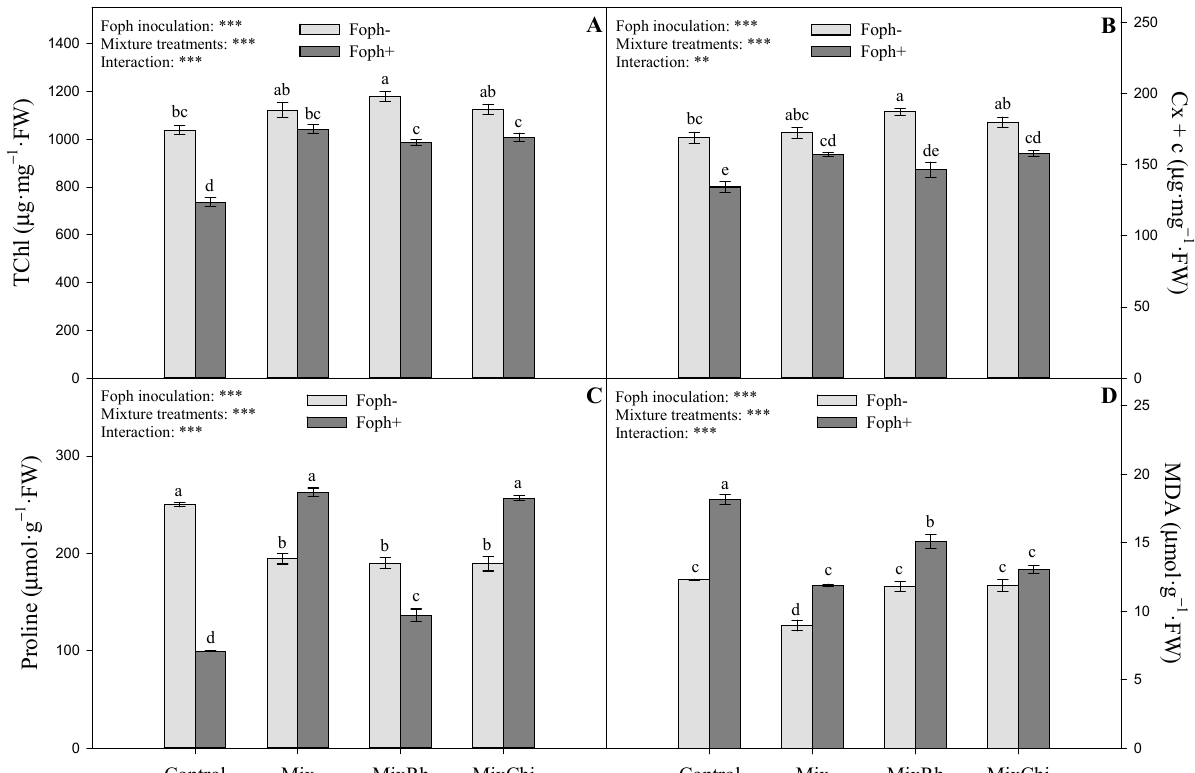
Figure 4. Effect of treatments with mixtures of biological control agents and organic additives (Mix ( T. virens + B. velezensis ), MixRh ( T. virens + B. velezensis + burnt rice husk), and MixChi ( T. virens + B. velezensis + chitosan) on the contents of ( A ) total chlorophyll (TChl) and ( B ) carotenoids (Cx + c), ( C ) proline and ( D ) malondialdehyde (MDA) of cape gooseberry plants without (light grey bars) and with (dark grey bars) of F. oxysporum f. sp. physali (Foph) inoculation at 50 days after inoculation. Error bars represent the mean of four values ± standard error. Significant differences between treatments are indicated by different letters according to the Tukey’s test ( p ≤ 0.05). ** p < 0.01 and *** p < 0.001—values of the ANOVA of Foph inoculation, mixture treatments and their interaction.